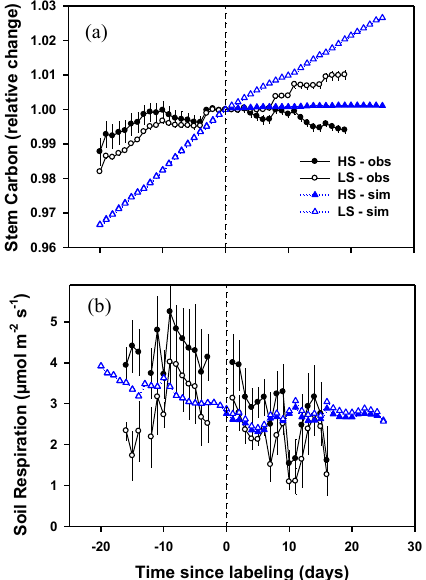
Figure 5. (a) Observed (obs) and CLM simulated (sim) daily stem carbon relative to day 0 ( ± SD); (b) soil respiration prior to and af- ter exposure to light shade (LS) and heavy shade (HS) treatments ( ± SD). Both observed and simulated stem carbon were normalized to 1 at day 0. The simulated soil respiration is the combination of au- totrophic respiration from roots and heterotrophic respiration from the decay of litter and soil organic matter. The vertical dashed lines indicate the starting day of the